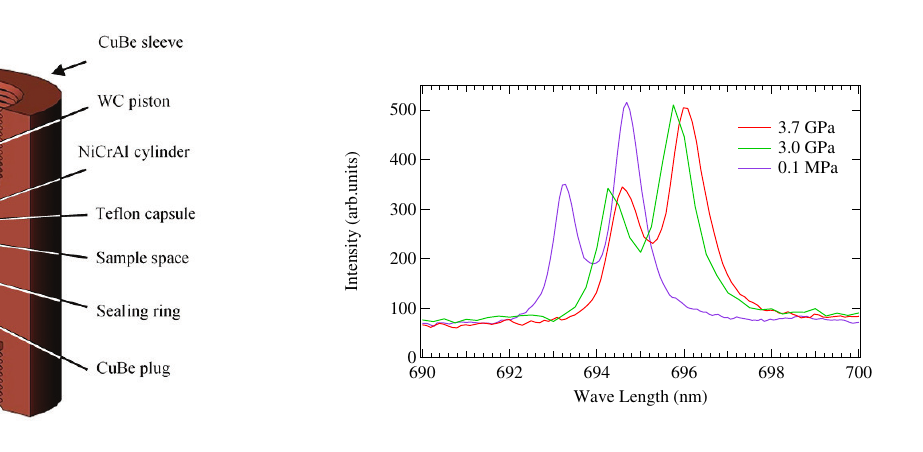
Figure 1: A NiCrAl-hybrid clamp-type pressure cell [8]. A coil wounded around the powder samples and an op- tical fiber with the Ruby powders were inserted into the sample space.